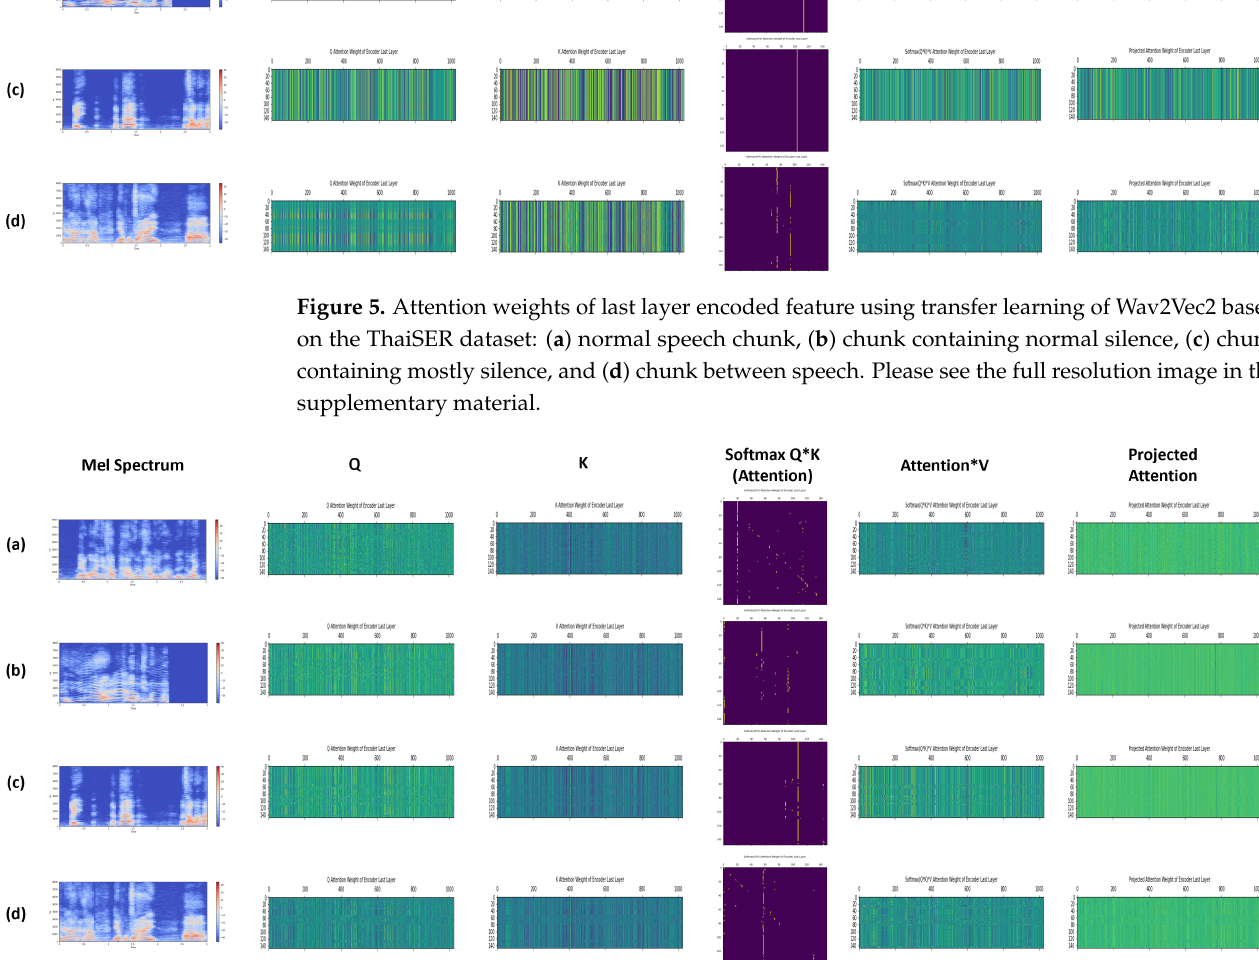
Figure 6. Attention weights of last layer encoded feature using fine-training of XLSR based on the ThaiSER dataset: ( a ) normal speech chunk, ( b ) chunk containing normal silence, ( c ) chunk containing mostly silence, and ( d ) chunk between speech. Please see the full resolution image in the supplementary